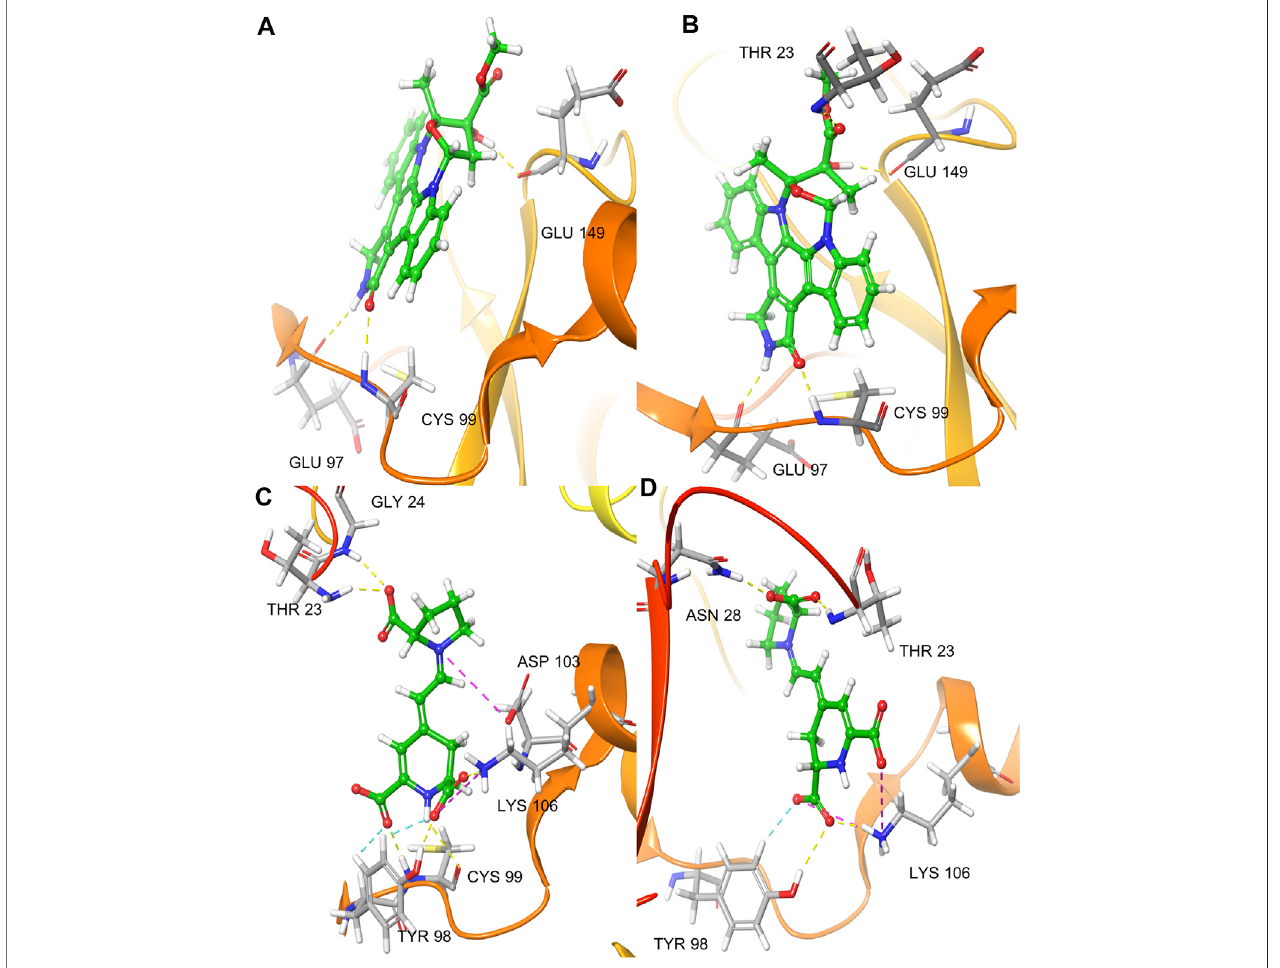
FIGURE3| IFDposeofK252aintheinactiveChainA (A) ;IFDposeofK252aintheactiveChainB (B) ;IFDposeofIndicaxanthinintheinactiveChainA (C) ;IFDpose ofIndicaxanthinintheactiveChainB (D) .H-bondsinteractionsarerepresentedinyellowdashes,aromaticH-bondsarerepresentedinlightbluedashes,thesaltbridges in purple